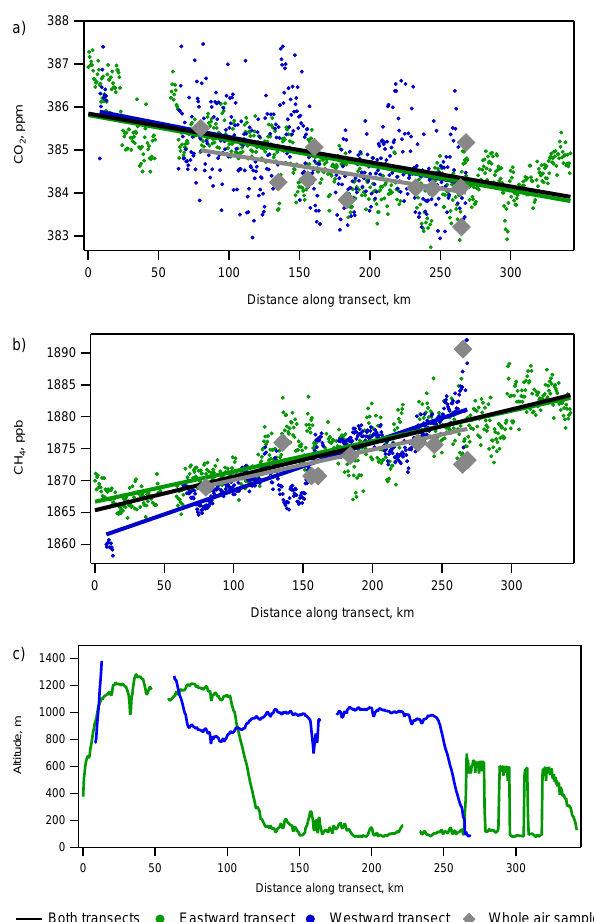
Figure 2. (a) CH 4 and (b) CO 2 observations along a flight transect, which was aligned with the prevailing wind direction. The origin is 20 ◦ E, 68 ◦ N and the transect extends in an eastward direction. The gradients observed in both species were used to determine a net emission flux for the region using Eq. (3). (c) The aircraft’s altitude when measurements shown in (b) and (c) were collected.